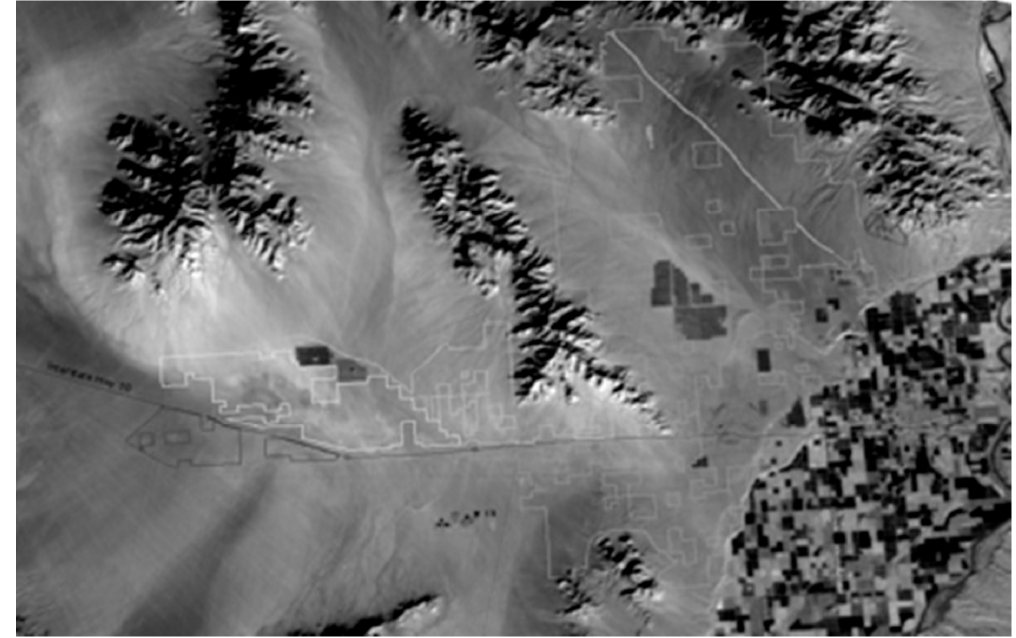
Figure 7. June 2016 Landsat LST gray-scale image, centered on the Palen and McCoy Wilderness Area in eastern Riverside County and the solar energy development zones (shown in white outlines). LST ranges from <40 o C in black shades to >50 o C in light gray shades.